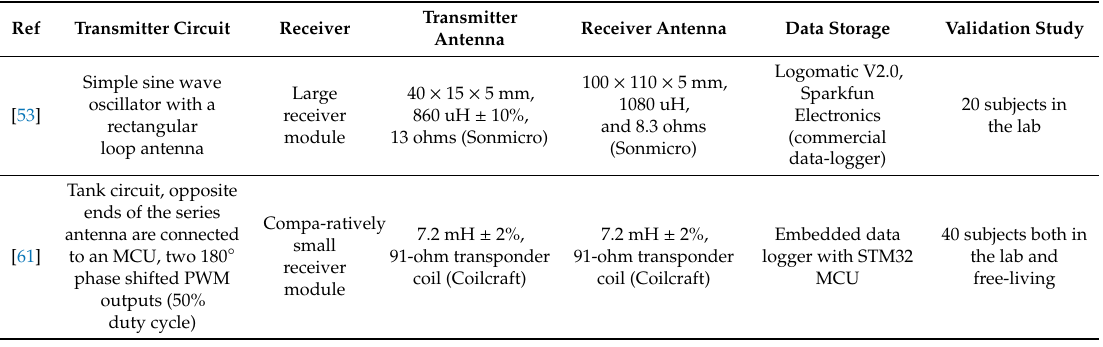
Table 5. Comparison of two versions of Radio Frequency (RF) Proximity sensors employed in smoking research.